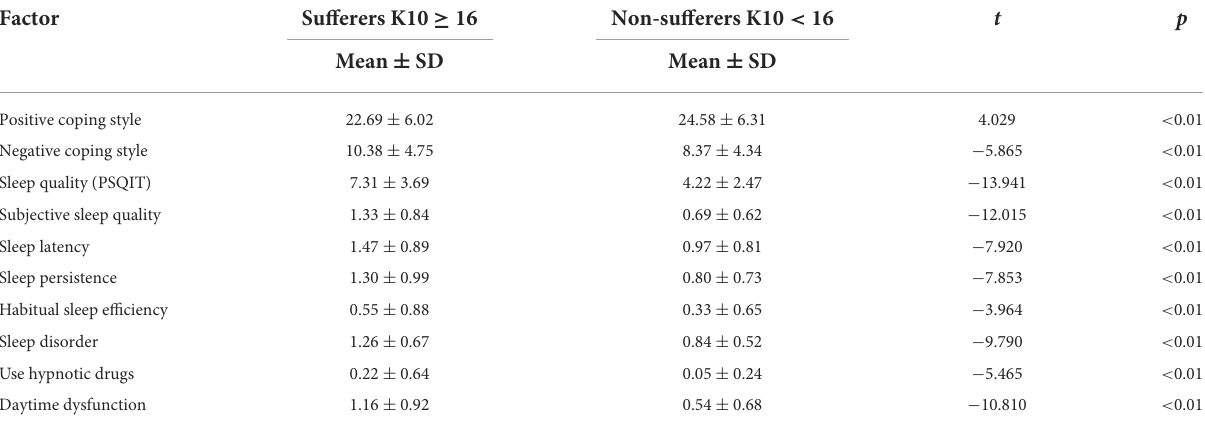
TABLE 2 Analysis of different groups of psychological distress among psychiatric nurses ( n = 812, Shandong, China).